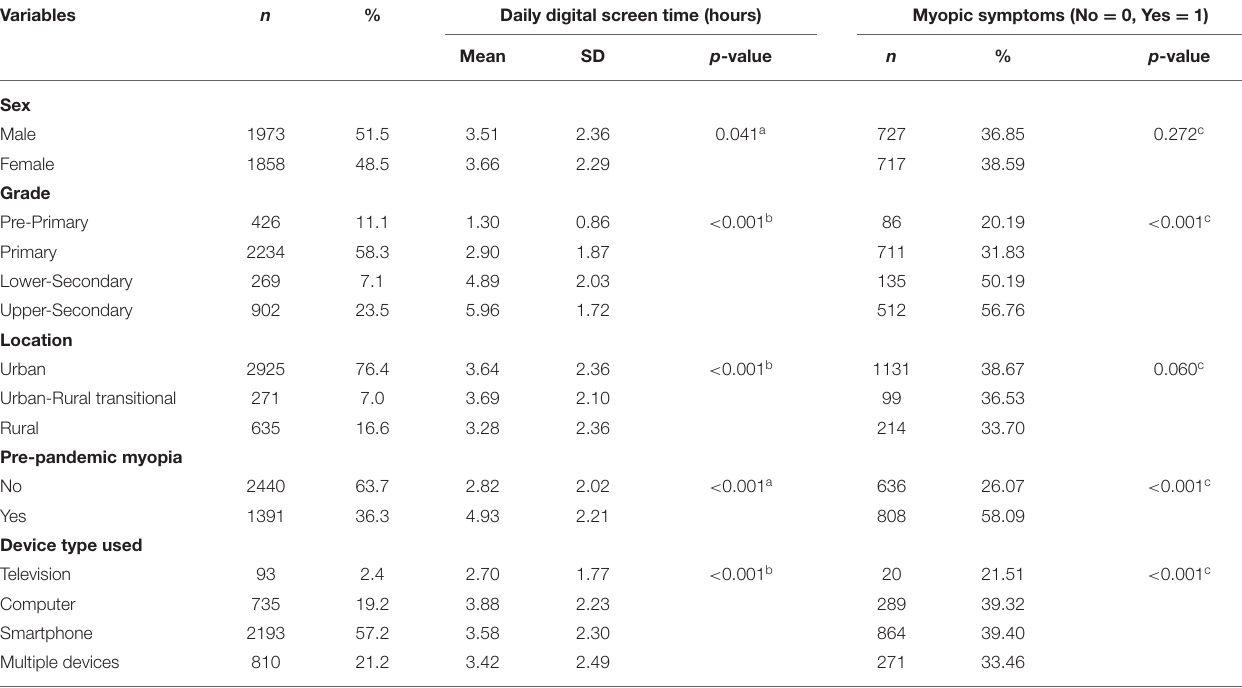
TABLE 1 | Prevalence of myopic symptoms and duration of daily digital screen engagement by individual traits ( N = 3,831).